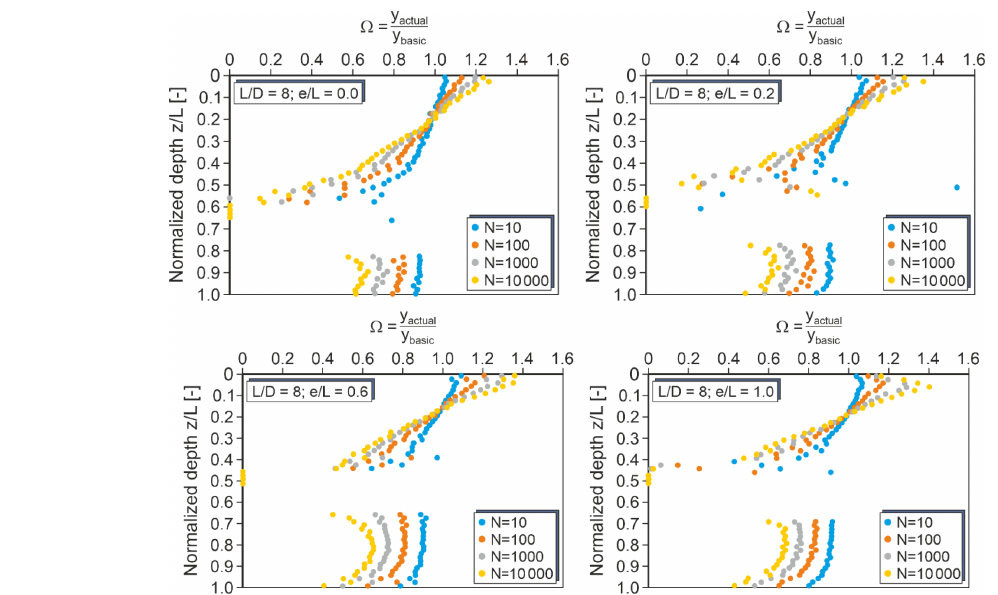
Figure 13. Correction factors (cid:127) for monopiles with L/D = 8 and different load eccentricities (very dense sand).